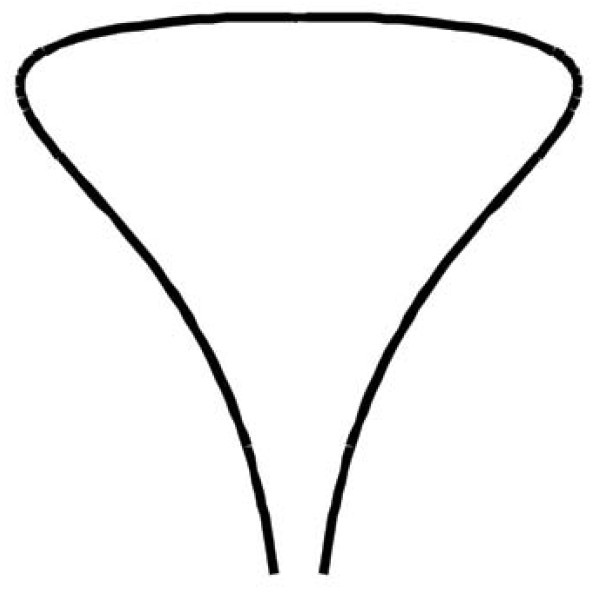
A surface of revolution with a funnel. The z-axis points down.